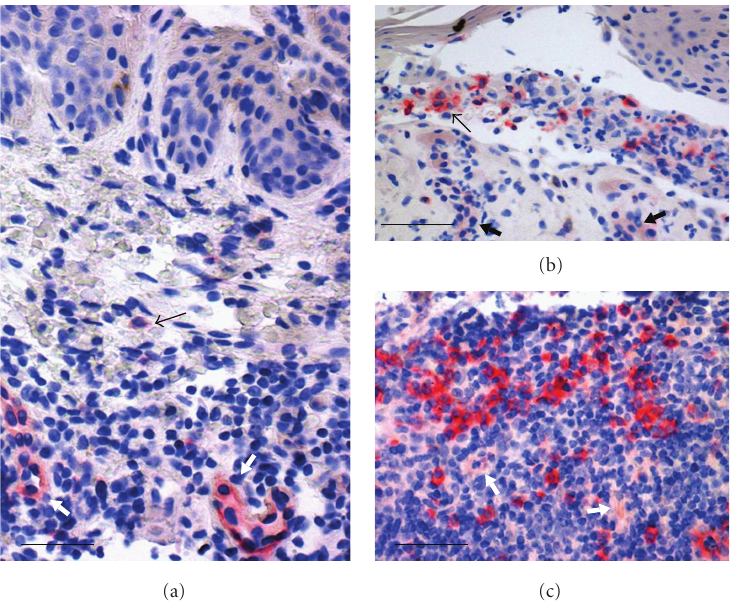
Figure 4: A few CD123+ pDCs, as the one indicated by the thin arrow, in the inflammatory infiltrate of a Darier’s disease case (a). In pemphigus vulgaris, CD123+ pDCs are more numerous, usually found in the dermis and/or inside the bulla ((b), thin arrow). A lichen ruber planus skin sample showing a high number of single or grouped CD123+ pDCs in the dermal inflammatory infiltrate (c). The endothelium of vessels ((a), (b), (c), thick arrows) is also weakly stained by the antiCD123 antibody. Immunohistochemistry; original magnification, × 200. Scale bar: A = 35 μ m; B, C = 45 μ m; Chromogen: